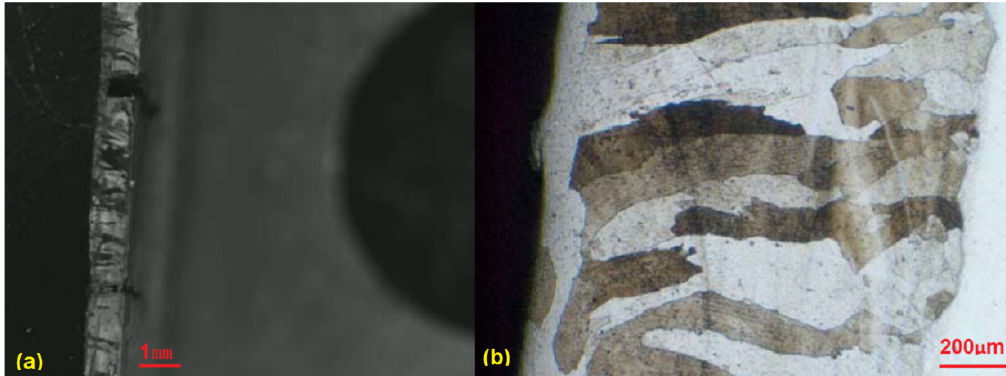
Figure 8. Metallographic analysis of the laser overlay plate ( a ) and the coating layer ( b ).